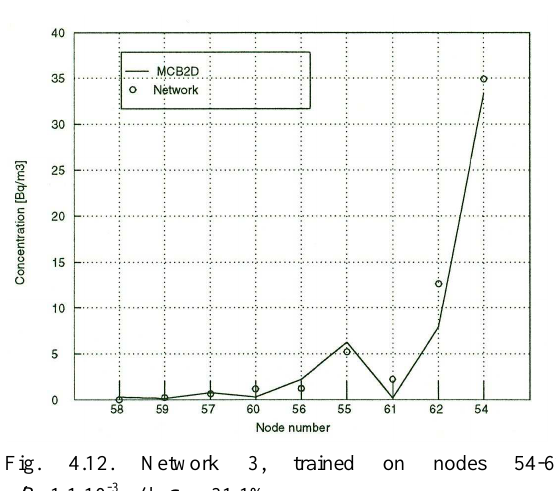
Fig. 4.12. Network 3, trained on nodes